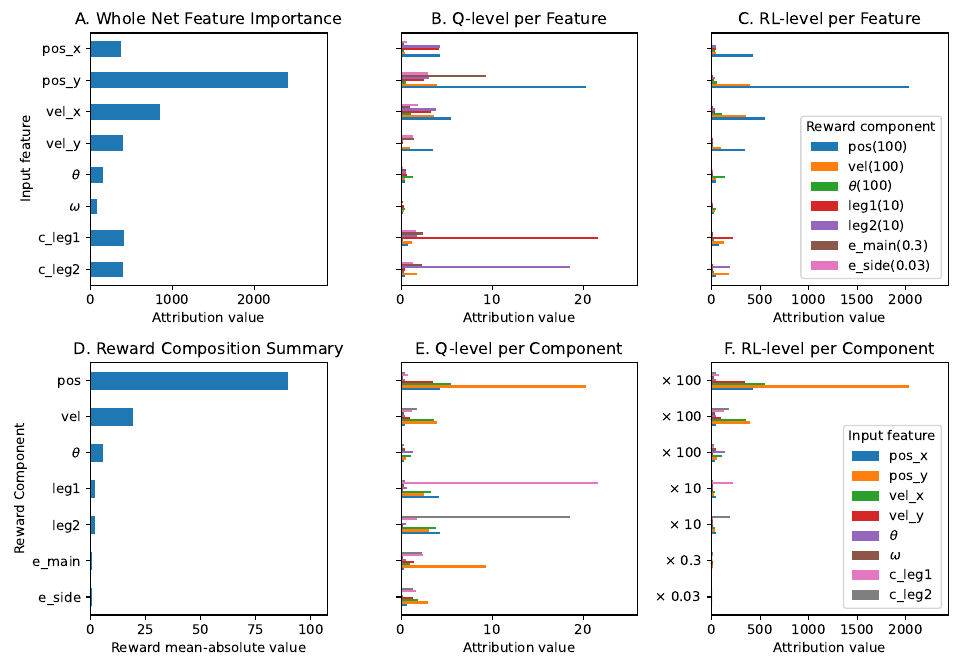
Figure A7. The global explanations of the Lunarlander agent.